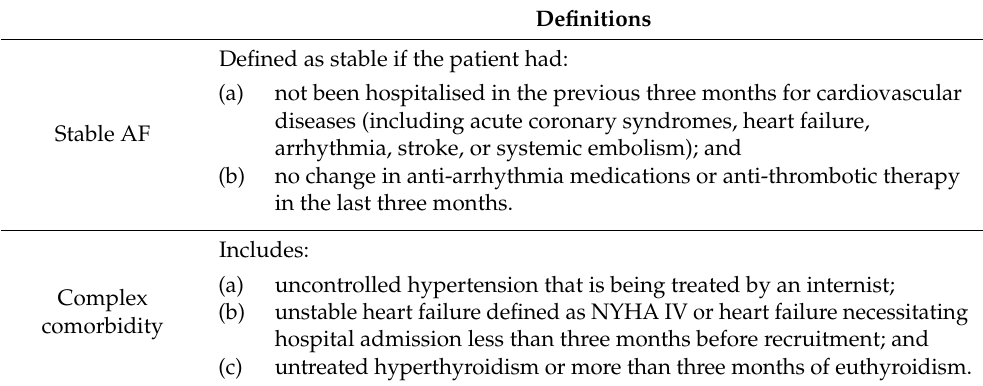
Table 1. Operating definitions.